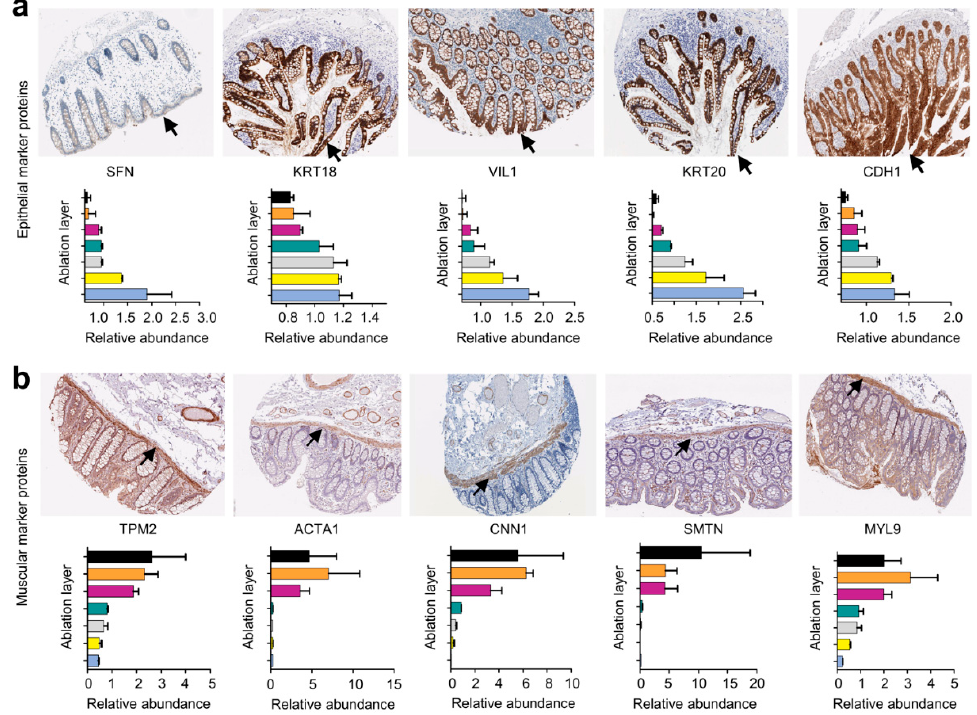
Figure 3. Abundance distribution of known epithelial and muscular proteins across different ablation layers. ( a ) Abundance distribution of established epithelial marker proteins ( SFN, KRT18, VIL1, KRT20 , and CDH1 ) across different ablation layers, associated with corresponding immunohistological staining of the human intestine, obtained from the Human Protein Atlas (v21.0.proteinatlas.org) [27]. ( b ) Abundance distribution of established muscular marker proteins ( TPM2, ACTA1, CNN1, SMTN, and MYL9 ) across different ablation layers, with corresponding immunohistological staining of the human intestine, obtained from the Human Protein Atlas (v21.0.proteinatlas.org) [27].